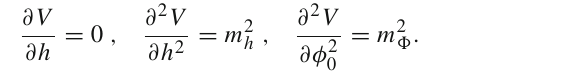
In the region enclosed by the dashed green line in the plane ( λ H (cid:2) , m (cid:2) ) of Fig. 5, v n / T n > 1; i.e. the phase transition